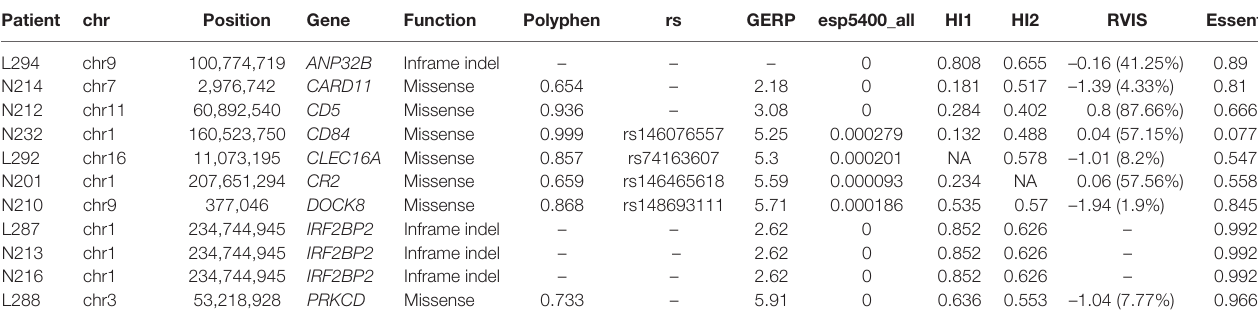
TaBle 3 | Functional heterozygous genetic variants with high predicted phenotypic effect at common variable immunodeficiency (CVID) candidate genes. Patient chr Position gene